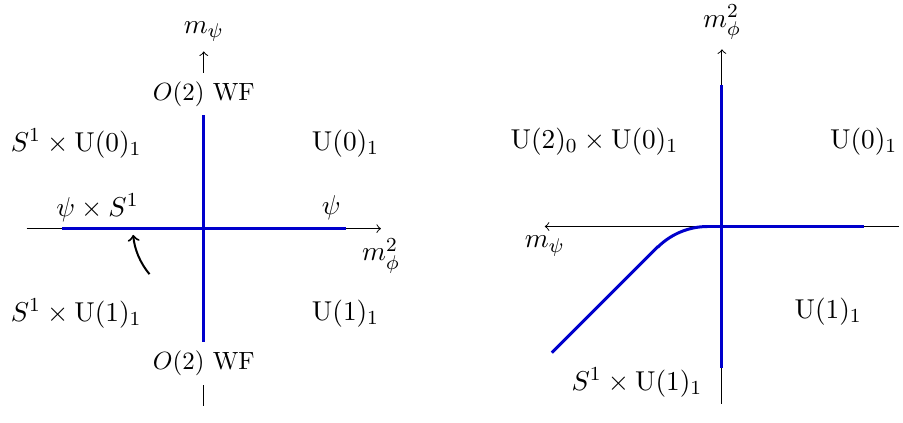
Figure 2 . O (2) WF